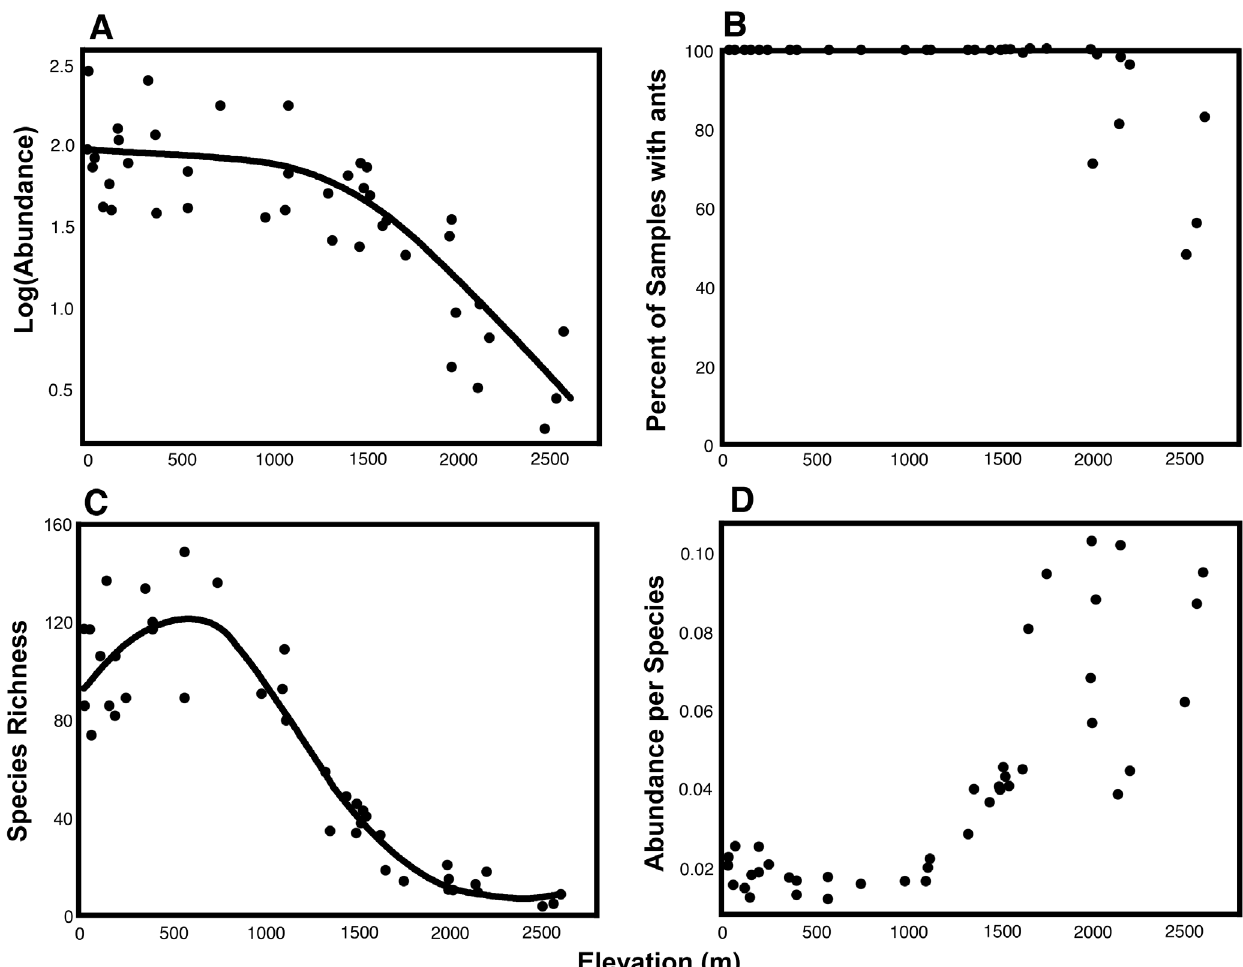
Figure 2. Ant abundance and richness variables as a function of elevation among 41 Central American wet forest sites. A. Log(Abundance)=average of 100 log[ n + 1] values where n =number of workers in 1 m 2 . B. Percent of samples containing ants. C. Species Richness=number of species in 100 samples (taxon subset; see text). D. Abundance per species=Abundance as defined in panel A/Richness as defined in panel C. LOESS curves are included for A and C, using default parameters in R 3.0.2.